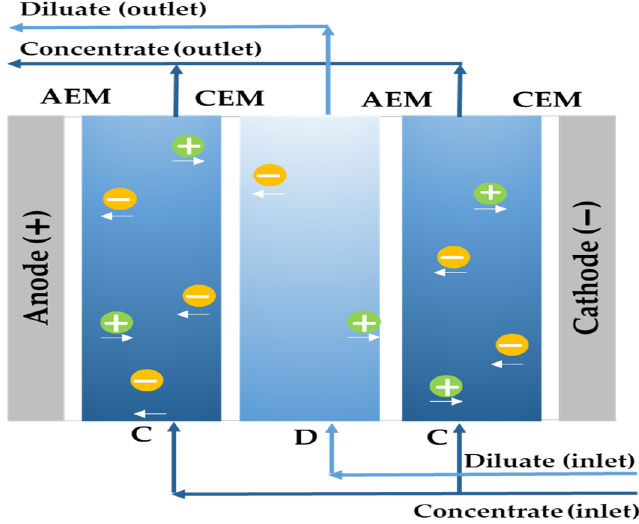
Figure 1. Diagram of the desalination principle for electrodialysis [12].